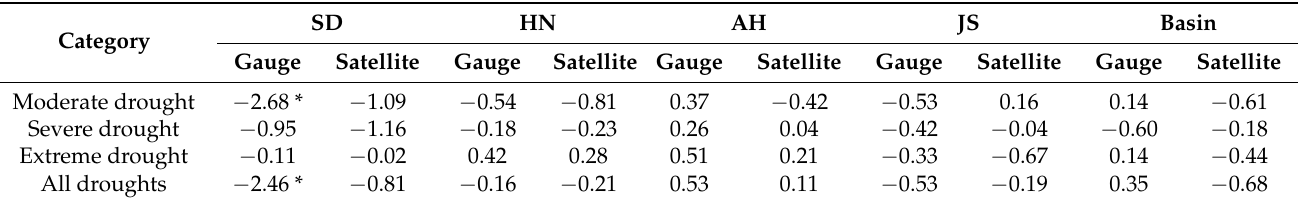
Table 2. Summary of trend analysis for drought frequency by Mann–Kendall test.